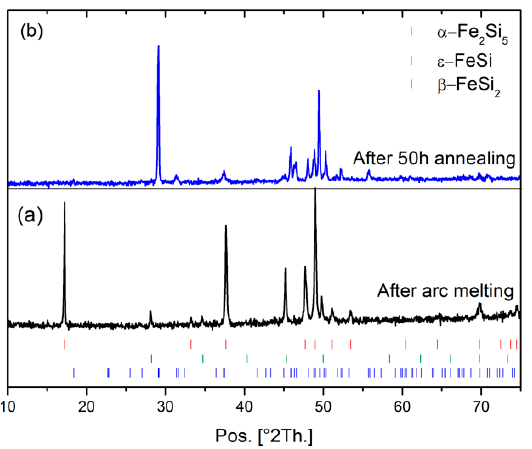
Figure 1. Diffraction pattern of β -FeSi 2 samples after ( a ) arc melting and ( b ) 50 h annealing.